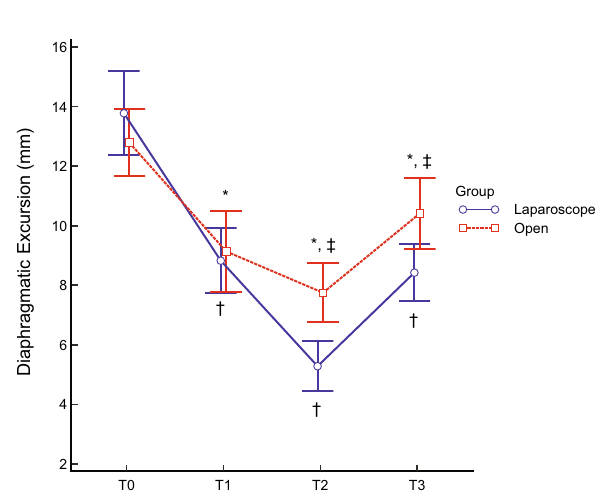
Figure 1. Diaphragmatic excursions at each surgical time point. Diaphragmatic movement decreased after anaesthetic induction and gradually decreased during the operation in both groups. Diaphragmatic excursions were significantly lower in patients undergoing laparoscopic (blue line) relative to those undergoing open (red line) surgery at T2 (P < 0.001) and T3 (P = 0.011). *P < 0.05 compared with T0 in patients who underwent open radical hysterectomy. † P < 0.05 compared with T0 in patients who underwent laparoscopic radical hysterectomy. ‡ Significant difference between the two groups. T0 = before intubation; T1 = after intubation; T2 = 90 min after the incision; T3 = at the end of the operation with recovery of muscle